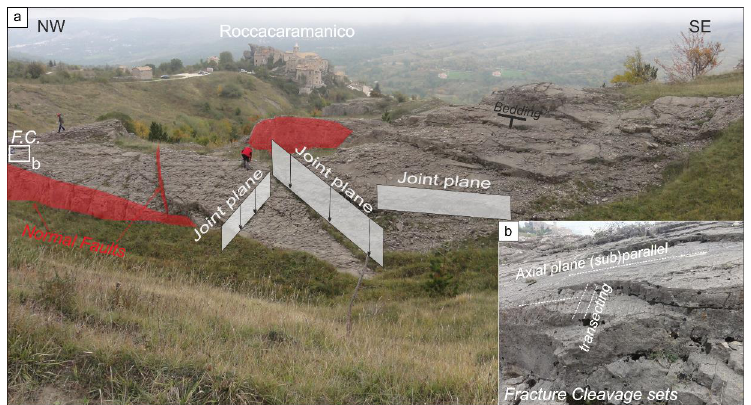
Figure 4. ( a ) Example of the bedding – joint plane observed in area A. The red polygons highlight the normal fault planes. ( b ) Details of the fracture cleavage sets (located in panel ( a )).